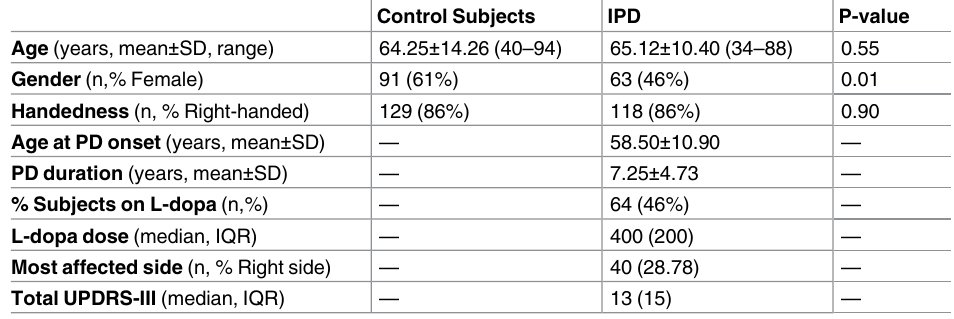
Table 1. Demographic characteristics.